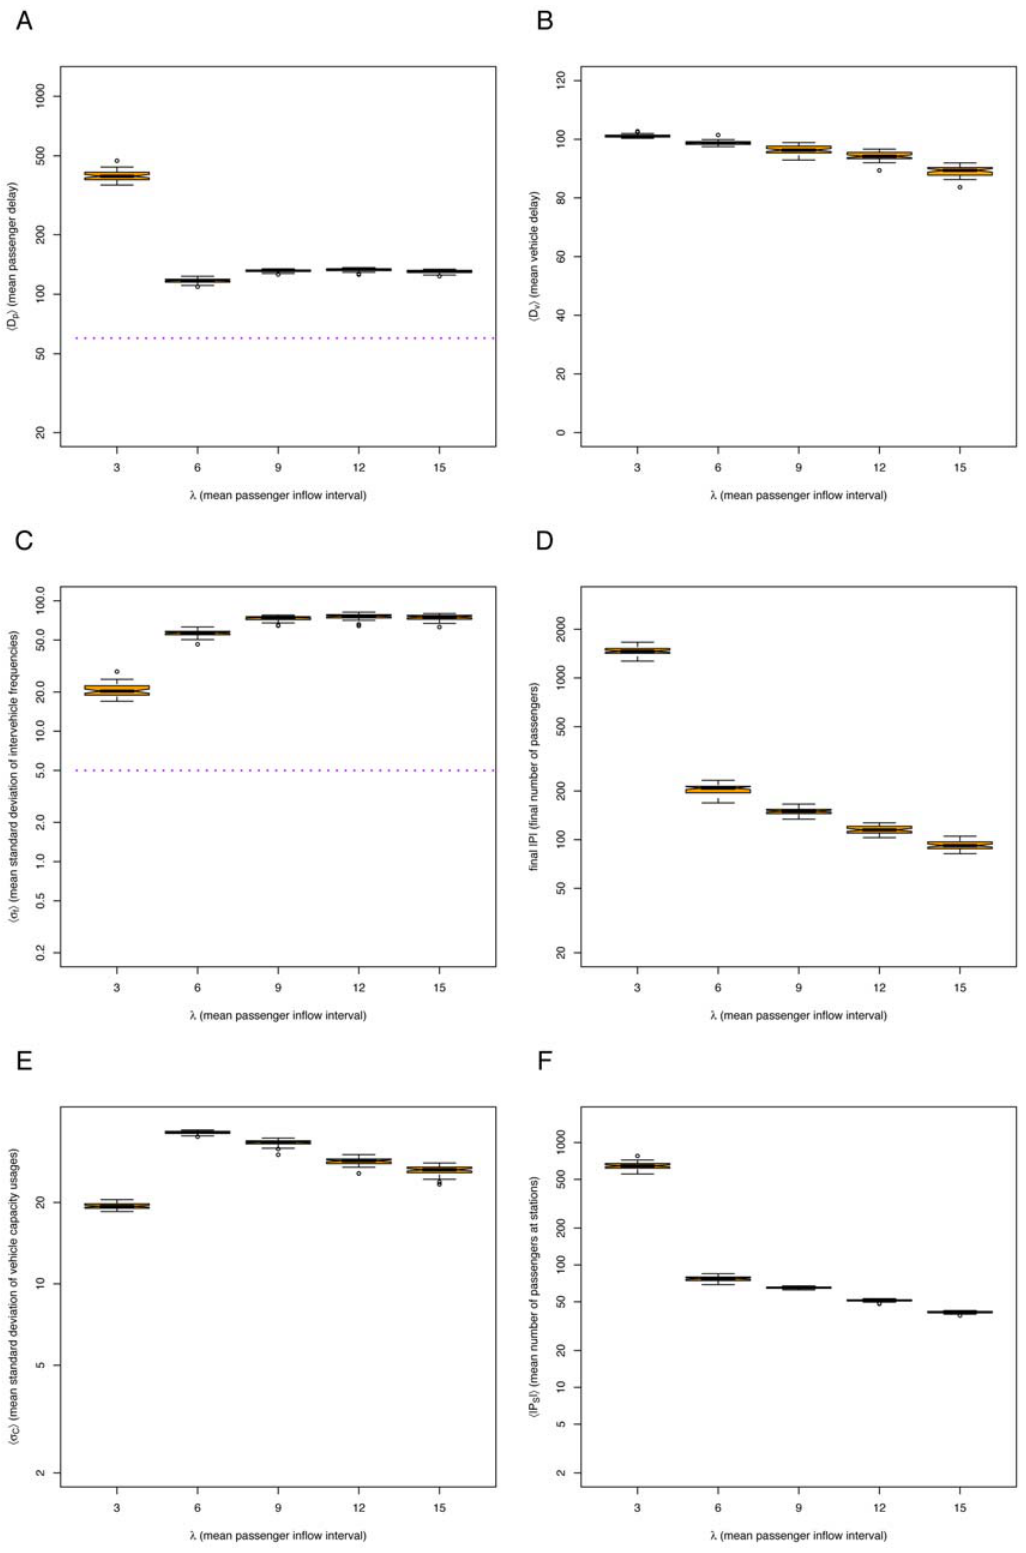
Figure 4. Simulation results for default method , varying mean passenger inflow intervals l and number of vehicles V j j ~ 5 : (A) mean passenger delay S D p T (data above horizontal dotted line indicates poor system performance), (B) mean vehicle delay S D v T , (C) mean standard deviation of intervehicle frequencies S s f T (data above horizontal dotted line implies unstable headways), (D) final number of passengers P j j , (E) mean standard deviation of vehicle capacity usage S s C T , and (F) mean number of passengers at stations S P s j j T . Notice log scale on y axis of all plots but (B).